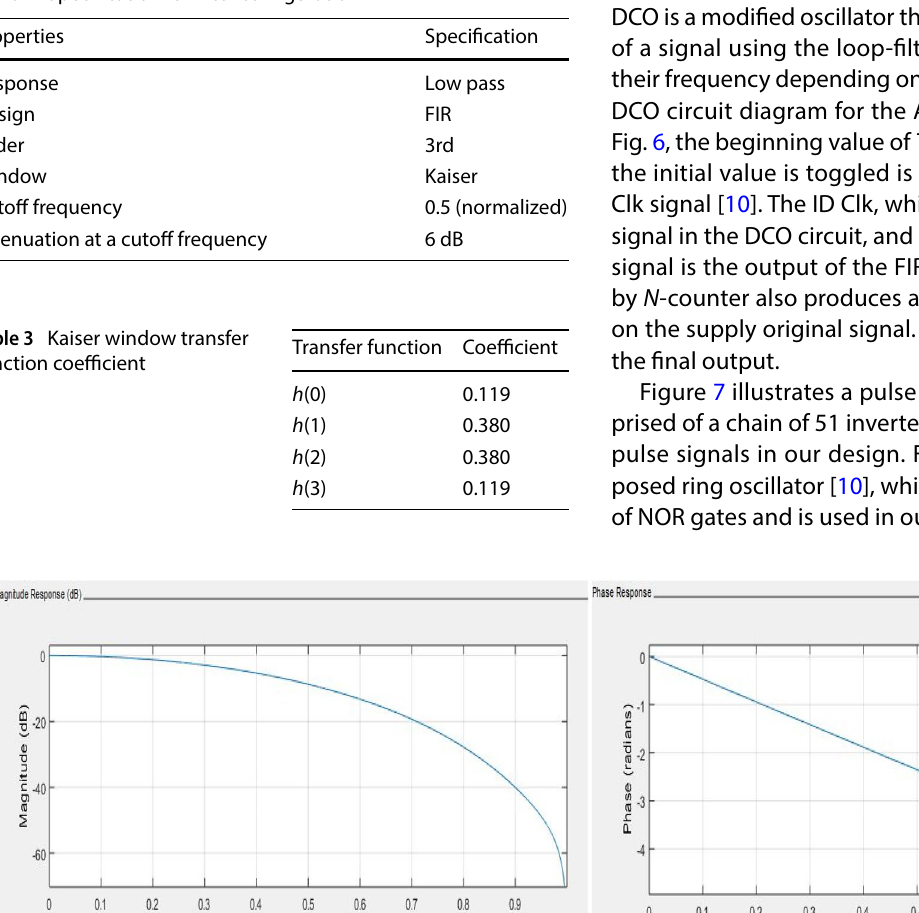
Table 2 Specification for filter configuration